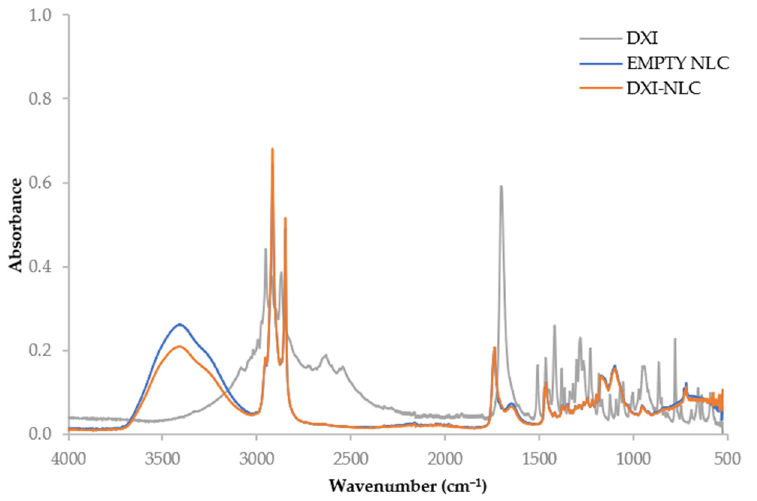
Figure 5. Fourier-transform infrared spectroscopy (FTIR) of DXI-NLC, DXI and empty NLC.